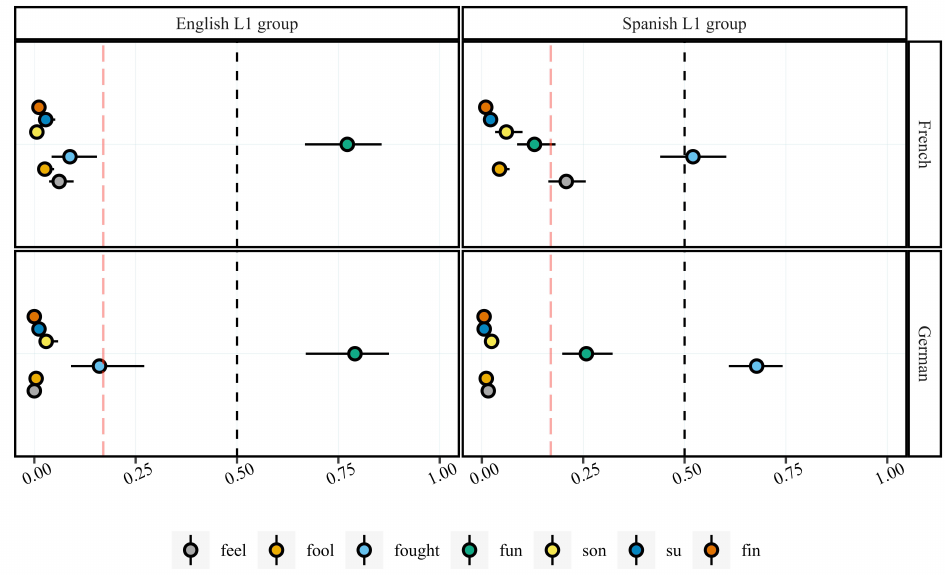
Figure 12. The probability of each answer choice given the phoneme / 2